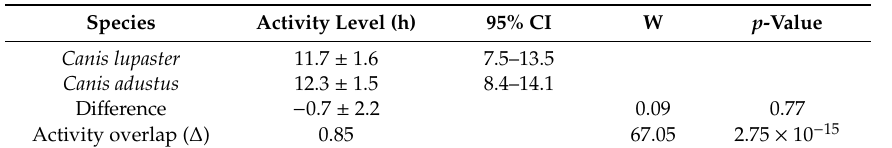
Table 1. Activity level (proportion of time spent at waterholes) and estimated coe ffi cient of activity overlap ( ∆ ) between African wolves and side-striped jackals based on detection records by camera trapping near artificial waterholes in the Ferlo region (Senegal). CI: Confidence interval, W: Mardia–Watson–Wheeler test statistic.